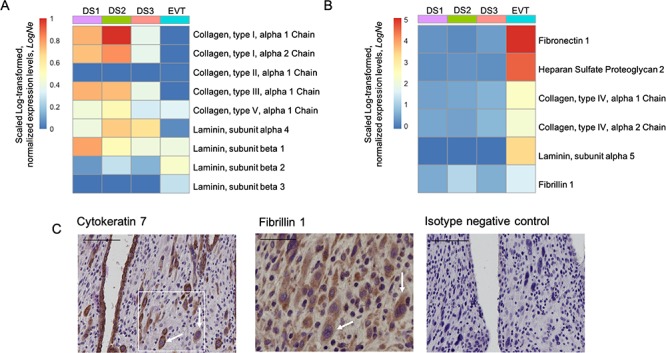

Contribution of ECM proteins to decidual stiffness. Analysis of single-cell RNA sequencing of first trimester decidua (data from Vento-Tormo et al., 2018) show normalized expression levels of RNA transcripts encoding selected ECM components. Panel (A) shows transcripts where scaled Log-transformed, normalized expression levels, LogNe in EVT \documentclass[12pt]{minimal}
\usepackage{amsmath}
\usepackage{wasysym}
\usepackage{amsfonts}
\usepackage{amssymb}
\usepackage{amsbsy}
\usepackage{upgreek}
\usepackage{mathrsfs}
\setlength{\oddsidemargin}{-69pt}
\begin{document}
}{}$\leq$}$$\end{document} 1 compared with three stromal cell subsets: DS1, DS2, and DS3 identified by scRNAseq. Data from Vento-Tormo et al., 2018. Panel (B) shows ECM transcripts where expression in EVT is more that in decidual subsets, LogNe\documentclass[12pt]{minimal}
\usepackage{amsmath}
\usepackage{wasysym}
\usepackage{amsfonts}
\usepackage{amssymb}
\usepackage{amsbsy}
\usepackage{upgreek}
\usepackage{mathrsfs}
\setlength{\oddsidemargin}{-69pt}
\begin{document}
}{}$\geq$}$$\end{document}1. Decidual stromal cell subsets DS1, DS2, and DS3 primarily express fibrillar collagens that provide mechanical strength. EVT cells primarily express ECM proteins that make up basement membrane. Fibrillin 1, a glycoprotein that is known to provide structural support in connective tissues, was found to be expressed by both EVT and stromal cells. (C) Protein expression of fibrillin 1 was confirmed by IHC on EVT cells. Serial sections of decidua basalis were stained for cytokeratin 7 (uterine glands and EVT) and fibrillin 1 (EVT and decidual stromal cells). Fibrillin panel shows staining of matching area to box on cytokeratin panel. White arrows indicate EVT with co-expression of both cytokeratin 7 and fibrillin 1 in serial sections (N = 3 biological replicates). Scale bars are 100 μm (cytokeratin panel) and 50μm (fibrillin panel).